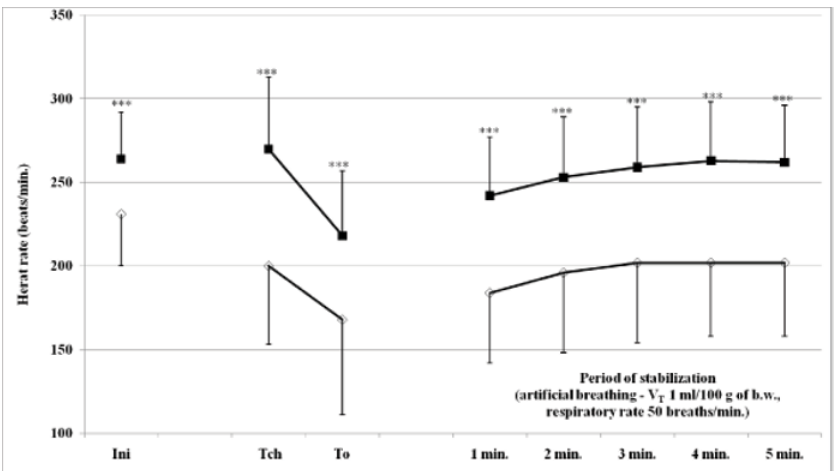
Figure 1. The average heart rate (HR) values ± SD before, during, and after the surgical interventions in the light (empty rhombus) and dark (black square) parts of the rat regimen day. Ini – intact; Tch – after tracheotomy; To – after thoracotomy and after 1-, 2-, 3-, 4-, and 5-minute periods of stabilization. *** p < 0,001 statistically significant differences between HRs measured during the light and dark part of the